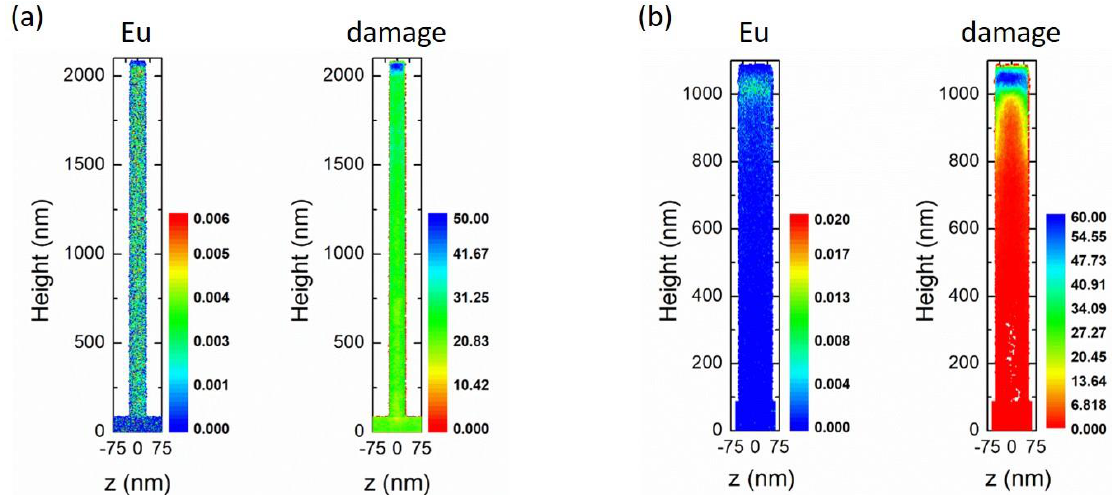
Figure 4. Monte Carlo simulations showing the Eu atomic fraction within the NW, as well as the damage distribution (in displacements per atom) in a longitudinal slice of 8 nm thickness along the NW length for the implantation of 3 × 10 15 at/cm 2 Eu ions at 300 keV and incidence angle of 20°. ( a ) For an array of 50 nm diameter NWs with an areal density of 2 × 10 9 cm −2 ; ( b ) for an array of 100 nm diameter and an areal density of 7 × 10 9 cm −2 . Adapted with permission from Ref. [45].